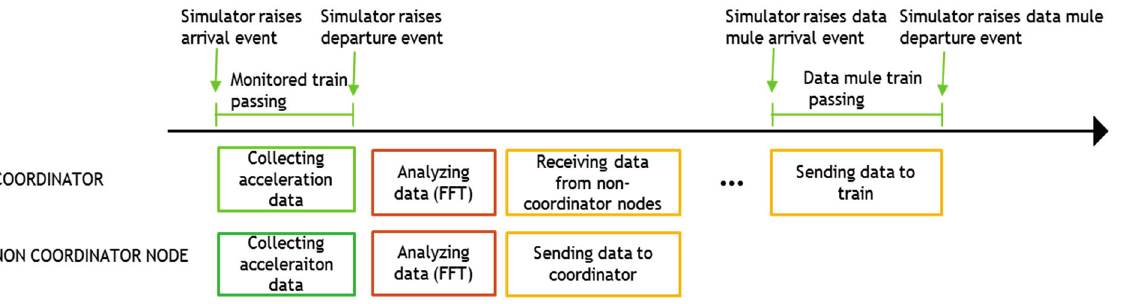
Figure 18. Node activity